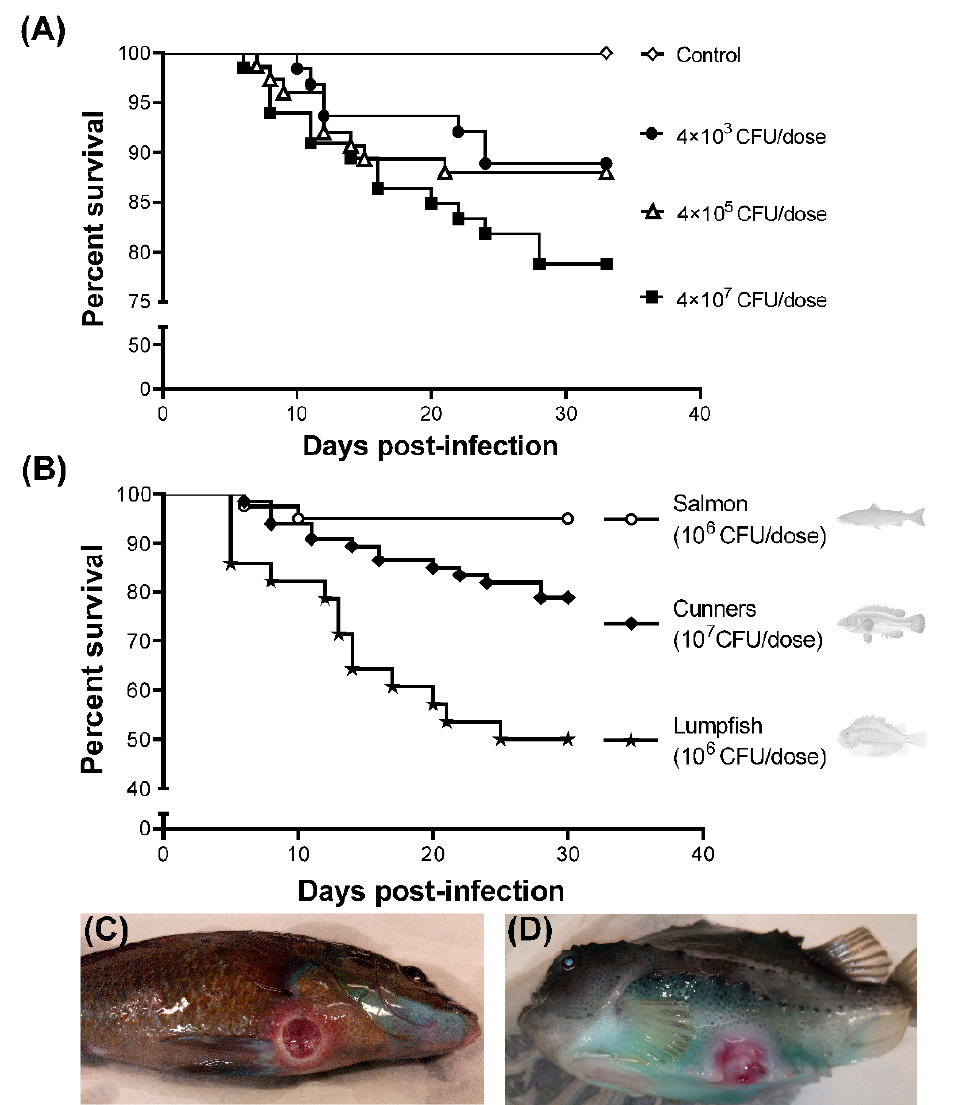
Figure 2. Pseudomonas sp. strain J380 is not an acute virulent pathogen to cunners ( Tautogolabrus adspersus ) and causes differential mortalities in hosts including, cunners, lumpfish ( Cyclopterus lumpus ), and Atlantic salmon ( Salmo salar ). ( A ) Survival assay for cunners injected with PBS (control), low (4 × 10 3 CFU), medium (4 × 10 5 CFU), and high (4 × 10 7 CFU) doses of Pseudomonas sp. J380 per fish. Mortality was monitored for 33 dpi. ( B ) The host-range of Pseudomonas sp. J380 was determined by survival assays in cunners, lumpfish, and salmon challenged with 4 × 10 7 , 1 × 10 6 , and 2.2 × 10 6 CFU/dose, and mortality was monitored for 30 dpi. ( C , D ) External clinical signs resulted from Pseudomonas sp. J380-infection in ( C ) cunner (7 dpi) and ( D ) lumpfish (5 dpi) at the advanced stage of skin ulceration. Refer to Figure S4 for additional